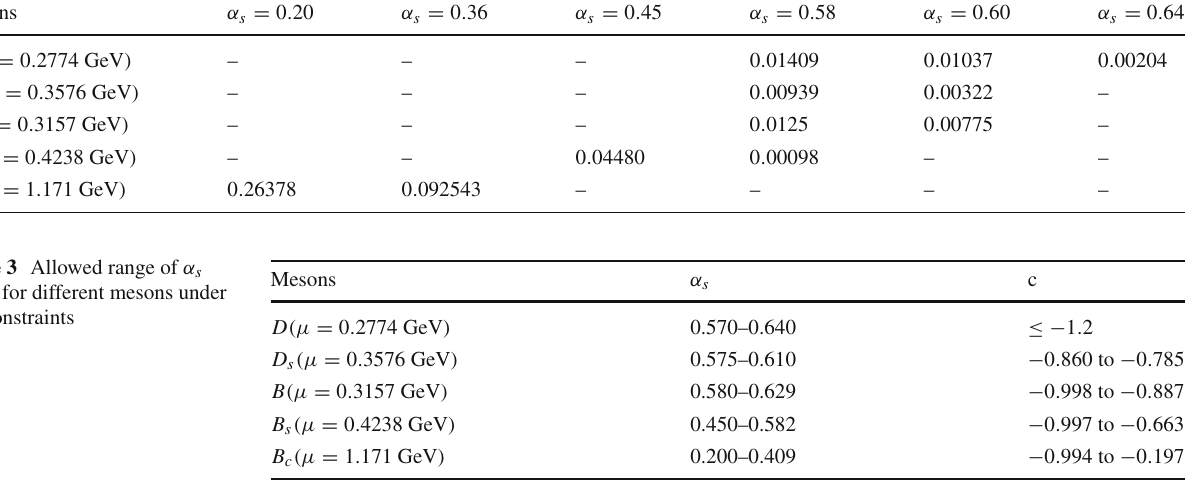
Fig. 1 Range of α s and c for D , D s , B , B S and B